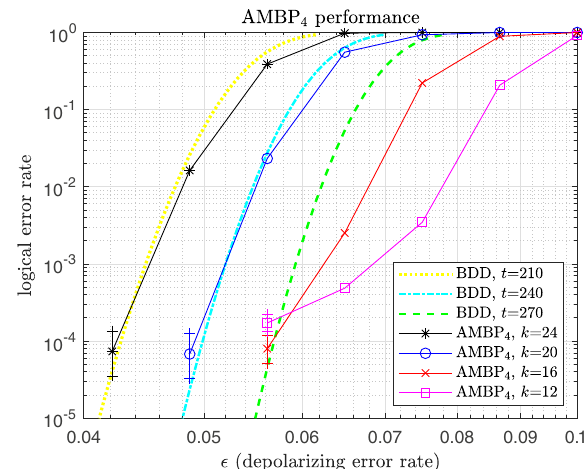
Fig. 2 Performance of serial AMBP4 on [[3786, 946]] bicycle codes. Each [[3786, 946]] bicycle code is constructed with a speci fi c row-weight k . Several BDD performance curves are provided for reference.